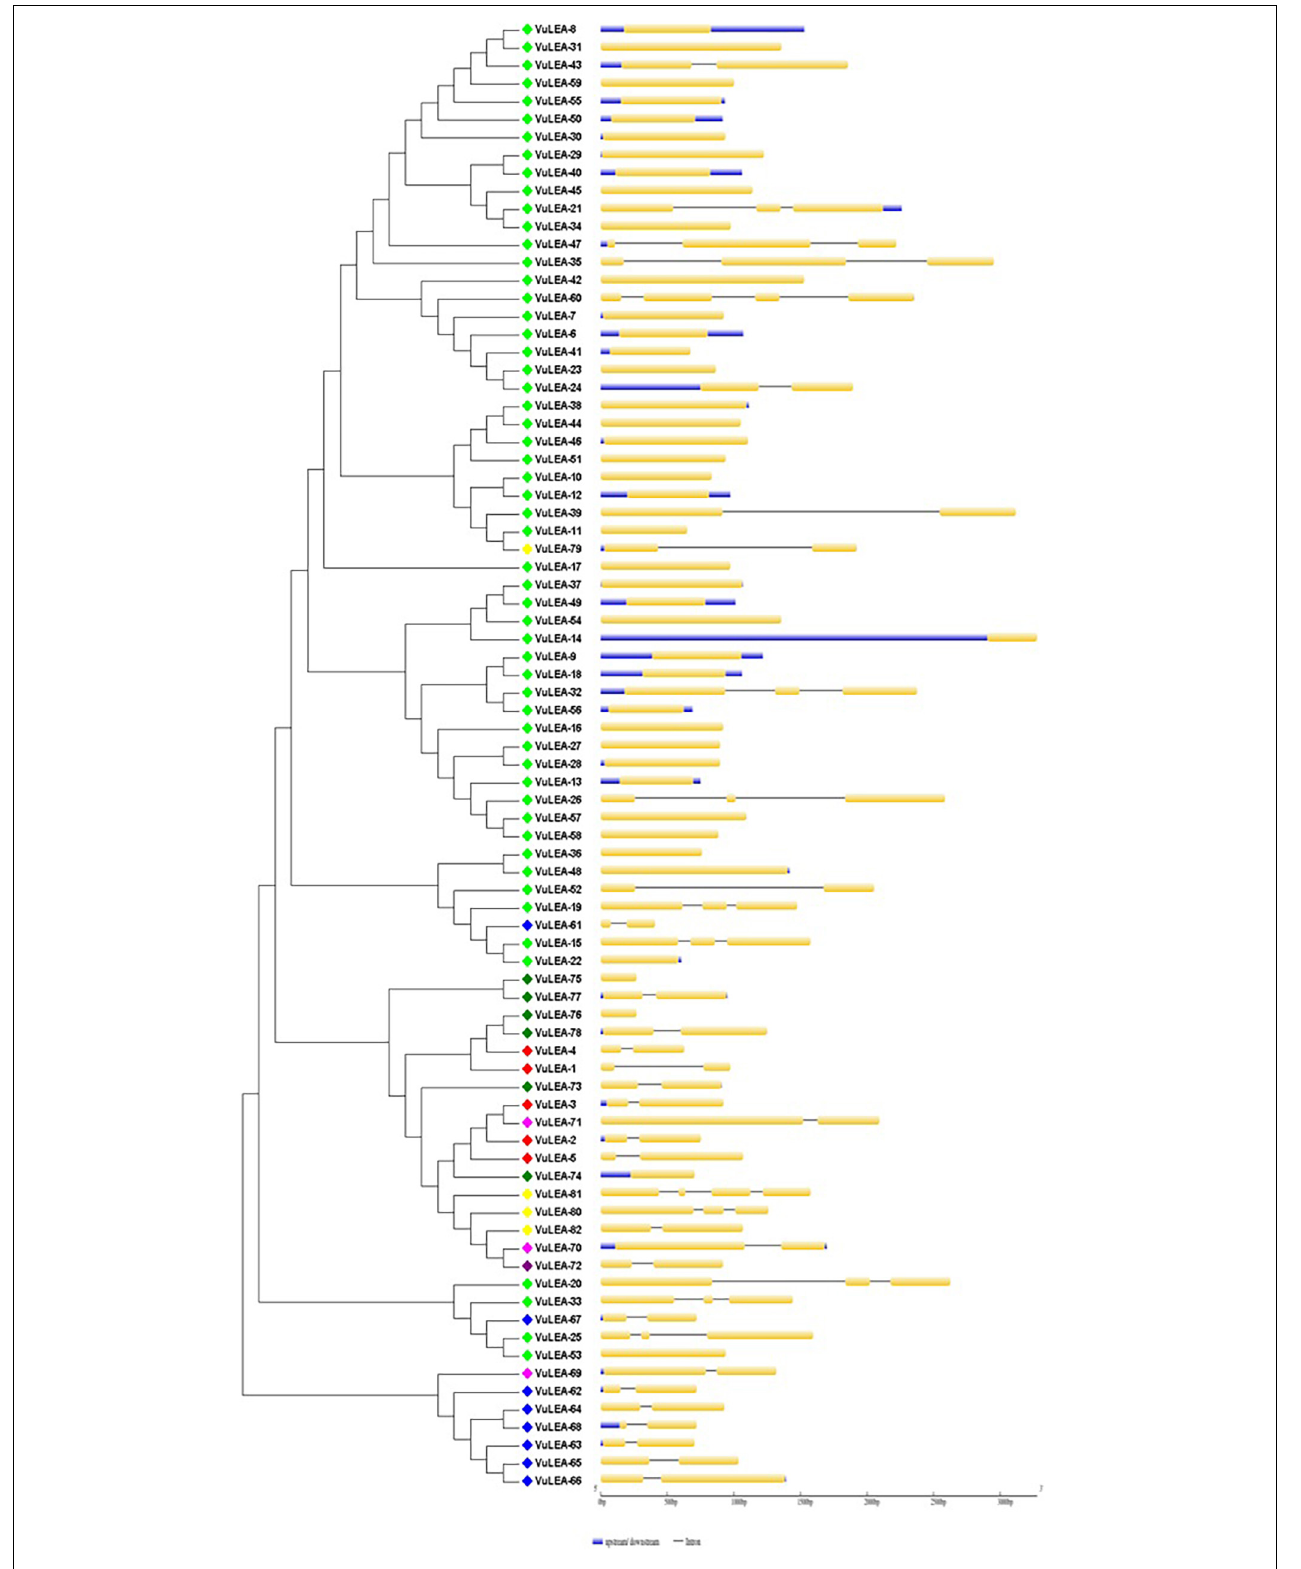
FIGURE 5 | Intron-exon gene structure analysis of VuLEA genes.